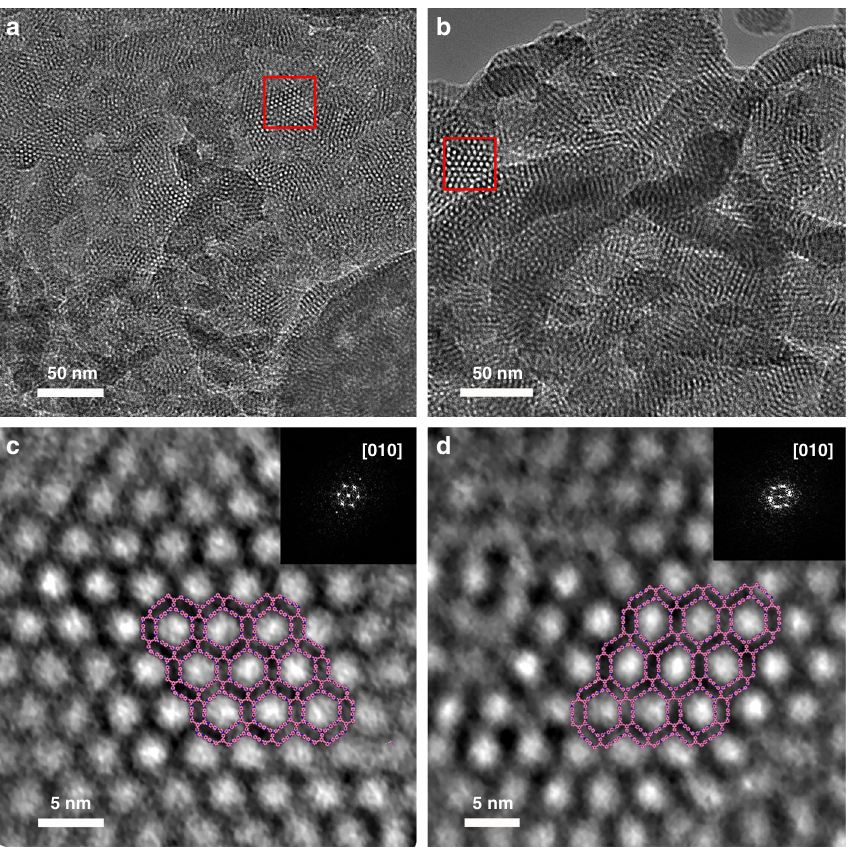
Fig. 8 TEM analysis. TEM images of a Tri-COF-BZ and b Tetra-COF-BZ, and HR-TEM images of c Tri-COF-BZ and d Tetra-COF-BZ focusing on the regions marked by the red squares in a and b at a higher resolution. The images inserted in the upper right corners are their corresponding FFT patterns, the structure projections in HR-TEM images are along the b -axis and the structural models are inserted in the